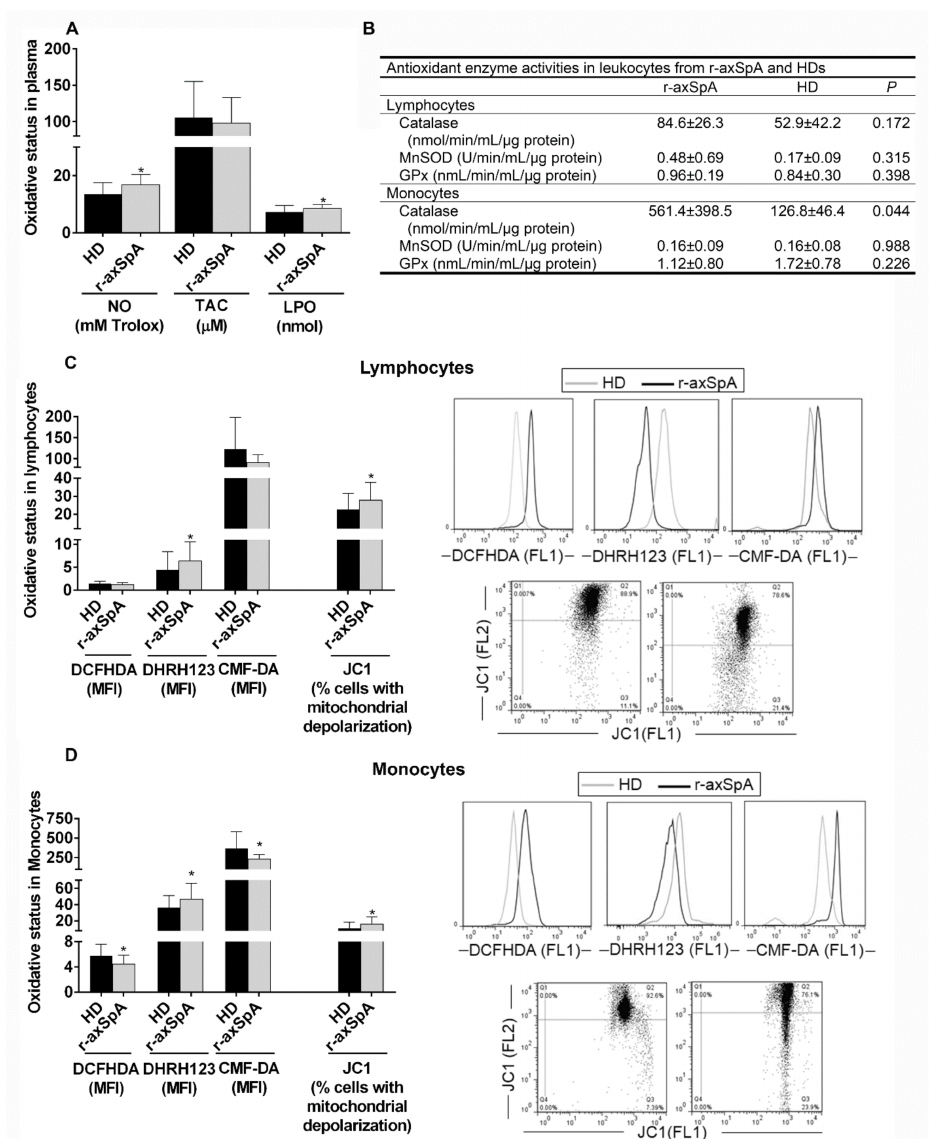
Figure 3. Oxidative status analysis in plasma and circulating mononuclear cells from r-axSpA patients. ( A ) Circulating levels of nitric oxide (NO), total antioxidant capacity (TAC), and LPO. ( B ) Catalase, mitochondrial superoxide dismutase (MnSOD), and glutathione peroxidase (GPx) in leukocytes from r-axSpA patients, and HDs. ( C , D ) Peroxide and perox- ynitrite production, intracellular glutathione (GSH) levels, and mitochondrial membrane potential in lymphocytes ( C ) and monocytes ( D ). Representative histograms and dot plots of an r-axSpA patient and HDs are shown in right panels. ( A – D ) Values are presented as means ± SD (HDs, n = 32; r-axSpA patients, n = 30). The data were analyzed using an independent samples t -test or a Mann–Whitney U test. * vs. HDs ( p < 0.05). HDs, healthy donors; r-axSpA, radiographic axial